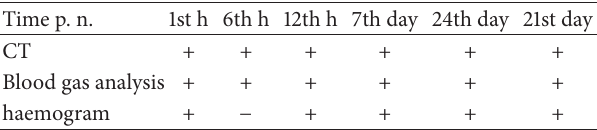
Table2:Timelineoftheoverallstudyforvital,healthycalves(group A: 𝑛 = 15 ). Time p.